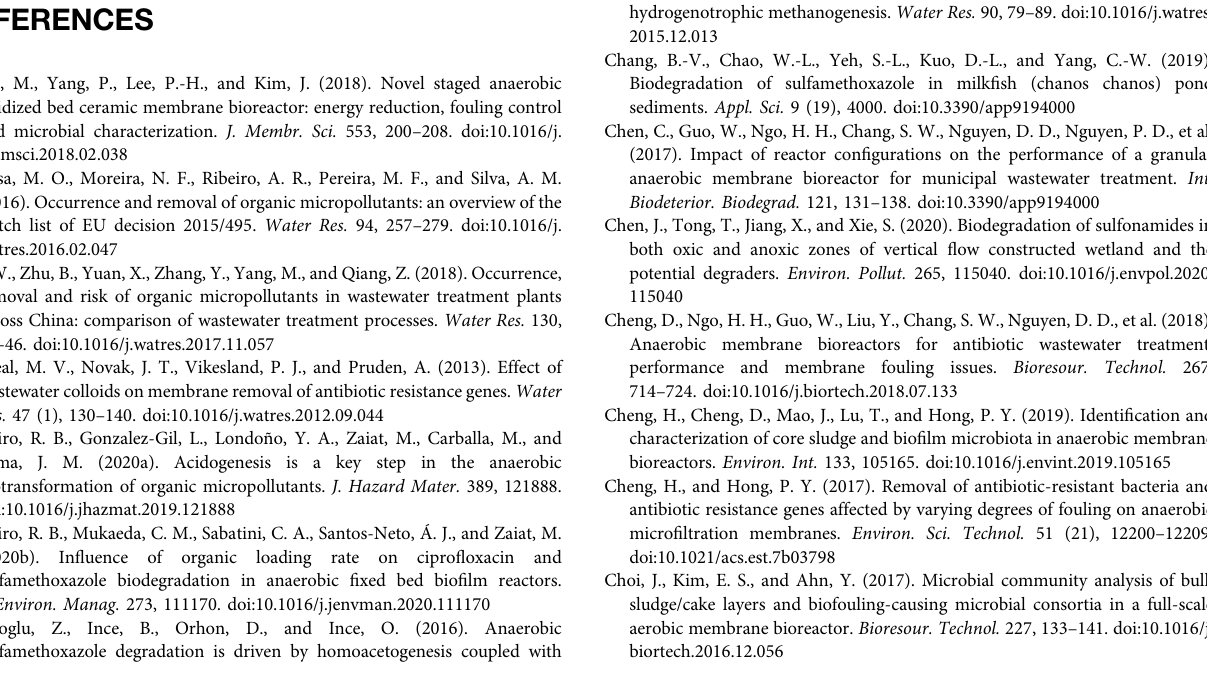
Frontiers in Chemical Engineering |